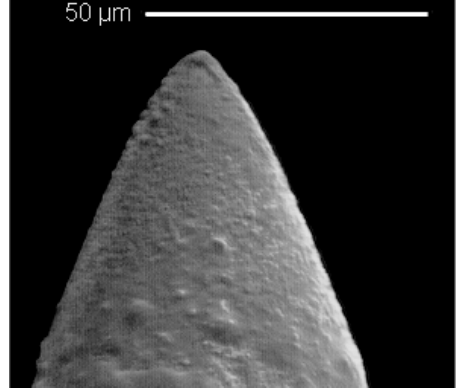
Fig. 1. REM image of an emitter needle.